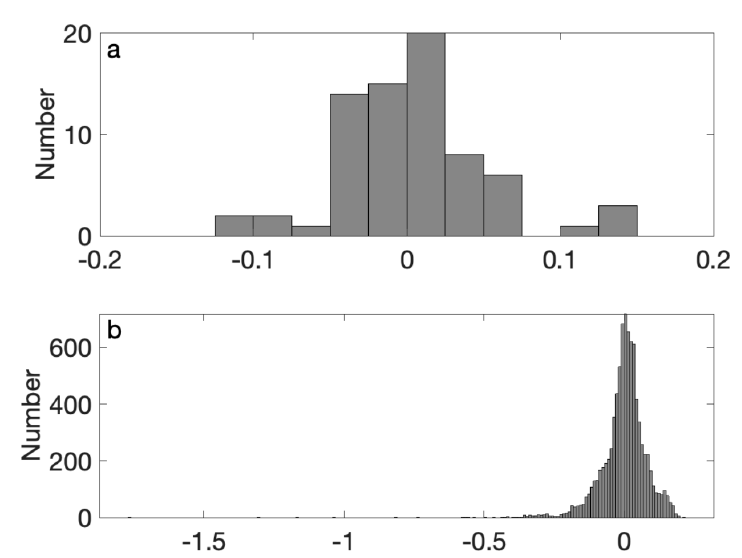
Figure 7. ( a ) Histogram of monthly anomaly of weekly weighted mean SSS in the SPURS-1 region. ( b ) Histogram of the monthly anomaly of individual SSS measurements. Note different axis limits in each panel, and the presence of extreme low outliers in panel b.